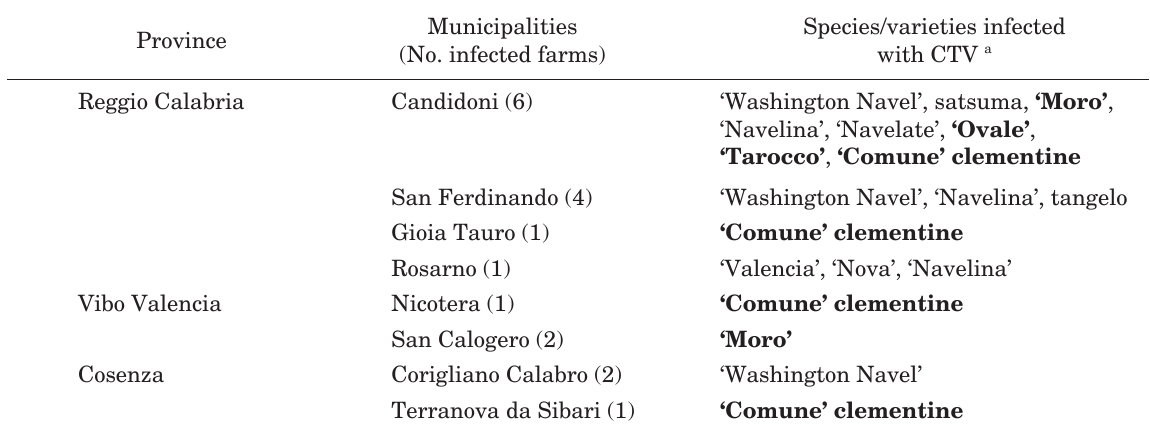
Table 2. Citrus species/varieties, located in farms of different municipalities per province, found infected with citrus tristeza